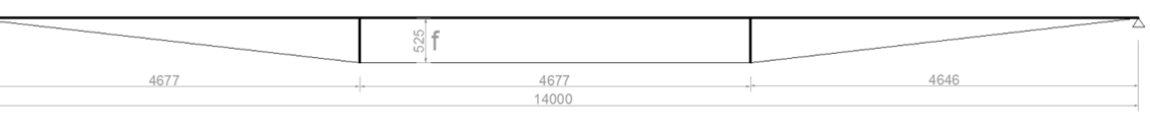
Fig. 5 The trussed beam principle